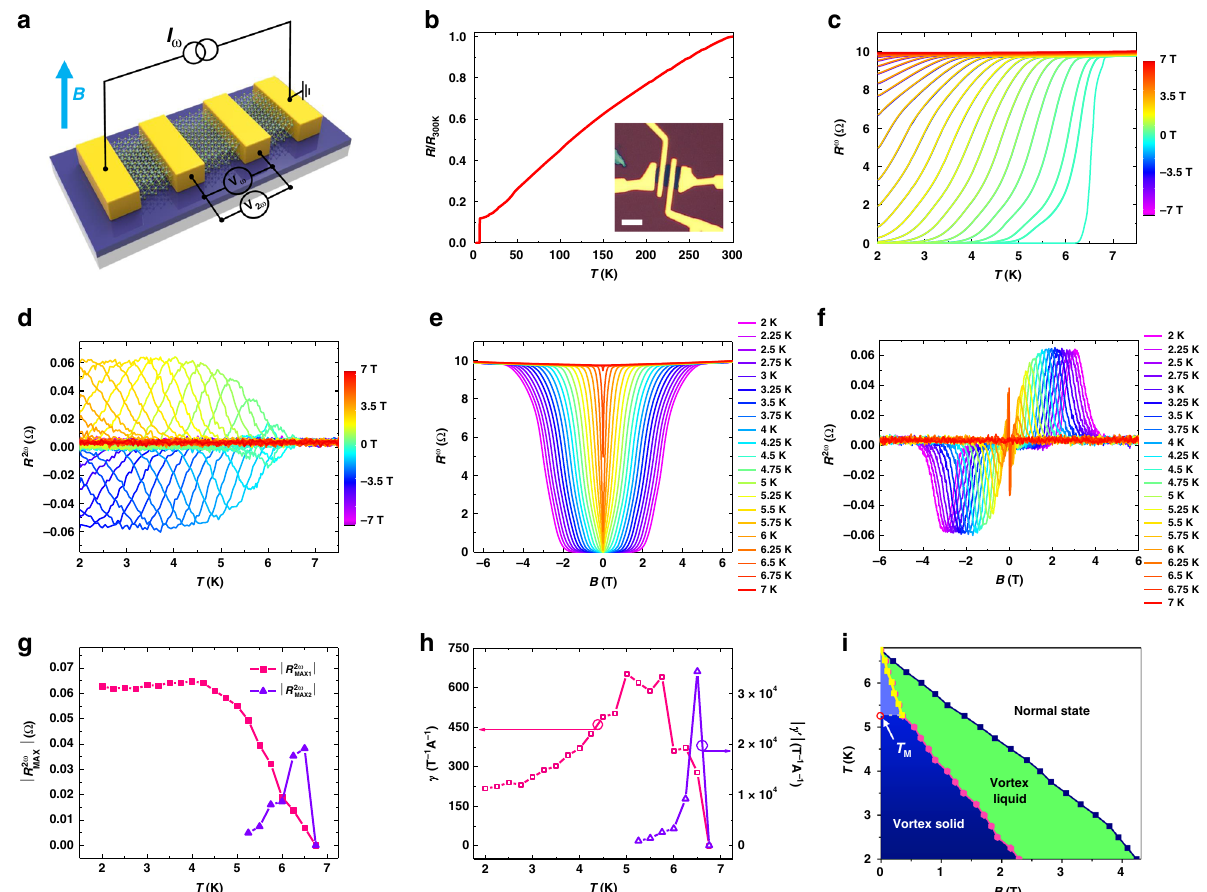
Fig. 2 Nonreciprocal charge transport in atomically thin NbSe 2 . a , Sketch of the four-terminal device based on atomically thin NbSe 2 . The magnetic fi eld is perpendicularly to the substrate plane. b , The temperature dependence of the normalized resistance of the NbSe 2 device. Inset, an optical image of the four-terminal NbSe 2 device with a thickness of fi ve layers. Scale bar, 5 μ m. c , d , Temperature-dependent R ω and R 2 ω of the device under positive and negative magnetic fi elds applied perpendicularly to the substrate, where R ω (B)-T and R ω (-B)-T curves overlap each other while R 2 ω (B)-T and R 2 ω (-B)-T curves are symmetric with respect to the x -axis ( I 0 = 25 μ A and f = 17.1 Hz). e , Magnetoresistance isotherm of the device with the temperature changing from 2 to 7 K, which are symmetric with respect to the y -axis. f , R 2 ω -B curves of the device at temperatures of 2 to 7 K, showing antisymmetric behavior at T < 7 K, which is consistent with the fi rst harmonic signal in ( e ). g , The extracted maximum value of R 2 ω -B curves R 2 ω (cid:1) (cid:1) (cid:1) (cid:1) stands for the peak values in the larger magnetic fi eld regime, the purple triangles R 2 ω pink squares R 2 ω MAX 1 magnetic fi eld regime at B ≥ 5.25 K. h , Calculated temperature-dependent γ and │ γ ′ │ , where γ ¼ opposite sign due to the opposite nonreciprocity. i , Temperature-magnetic fi eld phase diagram of the NbSe 2 device. The dark pink dots stand for crossover between the vortex solid (glass) state and vortex liquid state at which R 2 ω goes to zero. The dark blue dots show the crossing point of the vortex liquid state and normal state. R 2 ω goes to zero when further increasing the magnetic fi eld. The yellow dots are the crossing point where R 2 ω changes sign, de fi ning the boundary between the activated pinned vortex states (light blue area) and vortex liquid state at T M ≥ 5.25 K. Here T M is the melting temperature above which the vortex solid